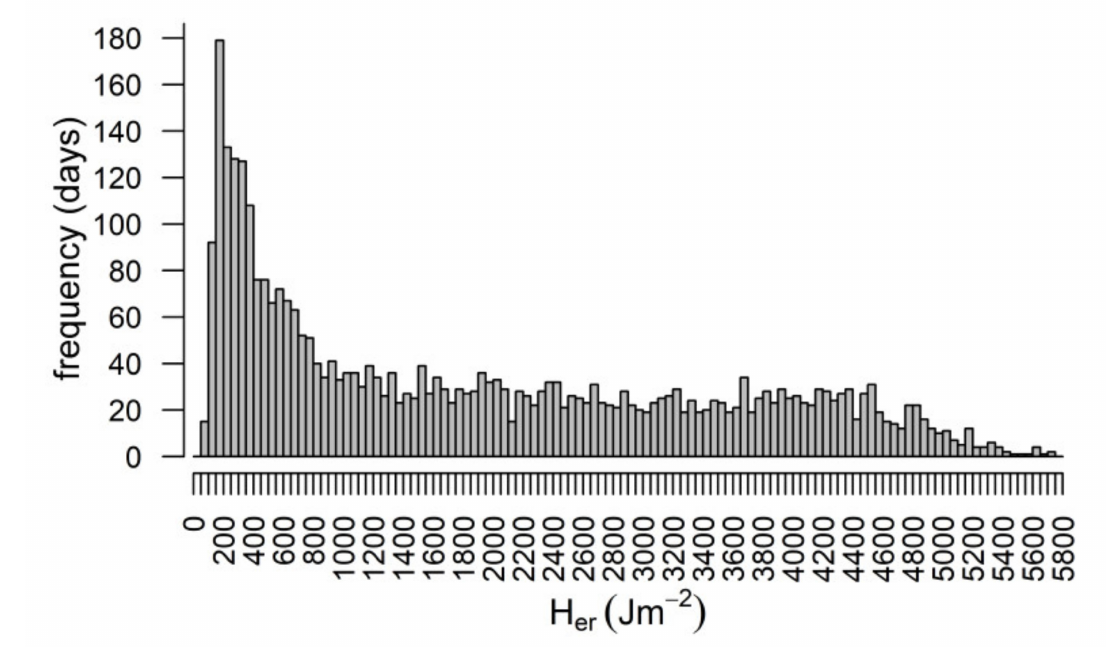
Figure 2. Frequency distribution of the daily H er in Novi Sad for the period 2003–2012. Figure 3 shows the evolution of the daily (black), monthly (red), and yearly average (blue) of H er (Jm − 2 ), TOC (DU), and cloud cover (tenths) in Novi Sad, Serbia, for the period 2003–2012. The curves of the daily and monthly H er show a sinusoidal evolution, with minimum monthly values in January and December that range between 189 Jm − 2 in December 2004 and 233 Jm − 2 in January 2008. Monthly maximum H er values ranged between 3358 Jm − 2 in June 2006 and 4582 Jm − 2 in June 2012. Daily H er values ranged between 68 Jm − 2 recorded on 12 December 2007, and 5733 Jm − 2 on 16 June 2012. As expected, TOC values were the highest in March and April (ranged between 327 DU in April 2011, and 392 DU in April 2010), and the lowest in October and November (ranged between 277 DU in November 2011, and 309 DU in October 2010). The lowest daily TOC of 227 DU was recorded on 25 December 2012. The lowest cloud cover was in July and August (ranged from 1.61 tenths in August 2012 to 5.06 tenths in August 2006), while the highest was in December in January (ranged from 4.97 in December 2003 to 8.71 in December 2010).